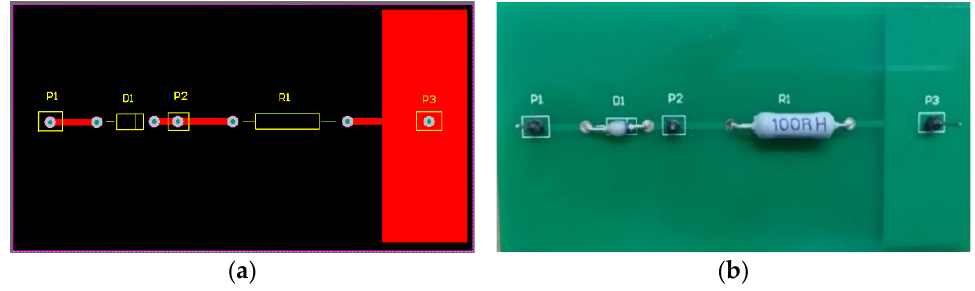
Figure 17. PCB board for model verification ( a ) design drawing; ( b ) Processed circuit board.